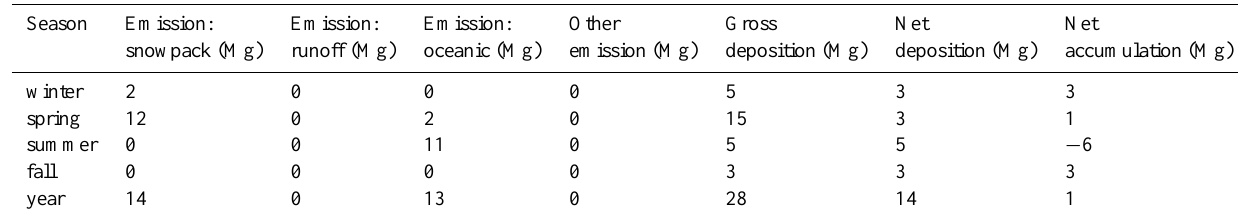
Table 2. Deposition and emission for the Hudson Bay System. Season Emission: Emission: